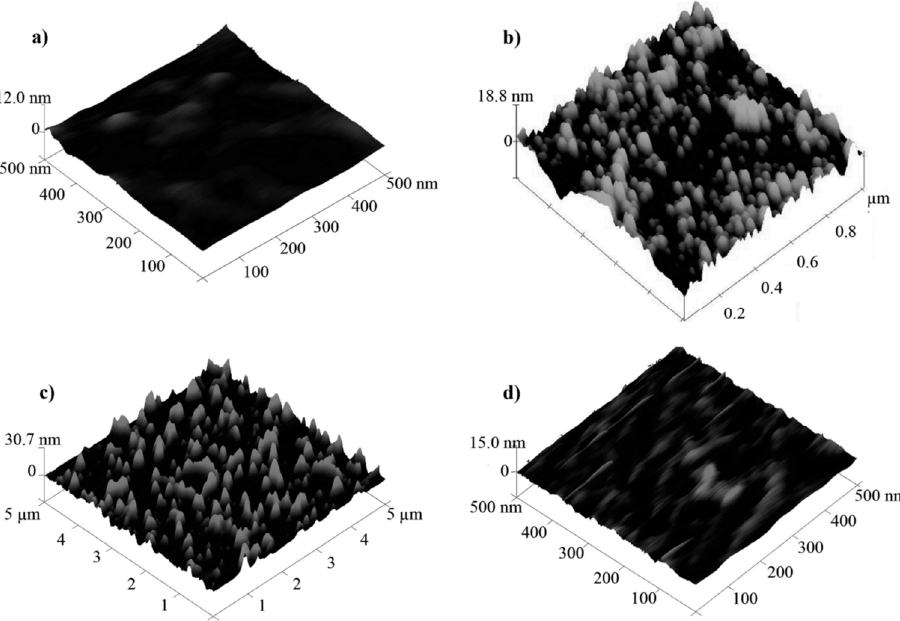
Figure 5. Contact mode AFM images of polyurethane layers: ( a ) nonimprinted polymer, ( b ) human rhinovirus (HRV) self-assembled on a surface, ( c ) molecular imprinting polymer (MIP) with partially removed template, and ( d ) MIP after washing (Reproduced with permission from Reference [69]).